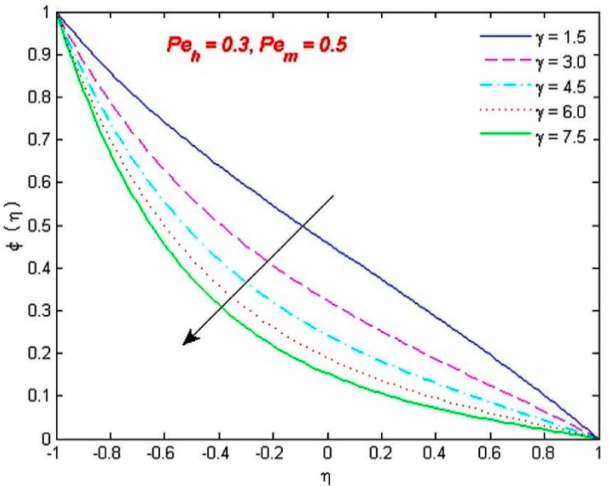
Figure 7. Change in concentration for various values of chemical reaction parameter γ